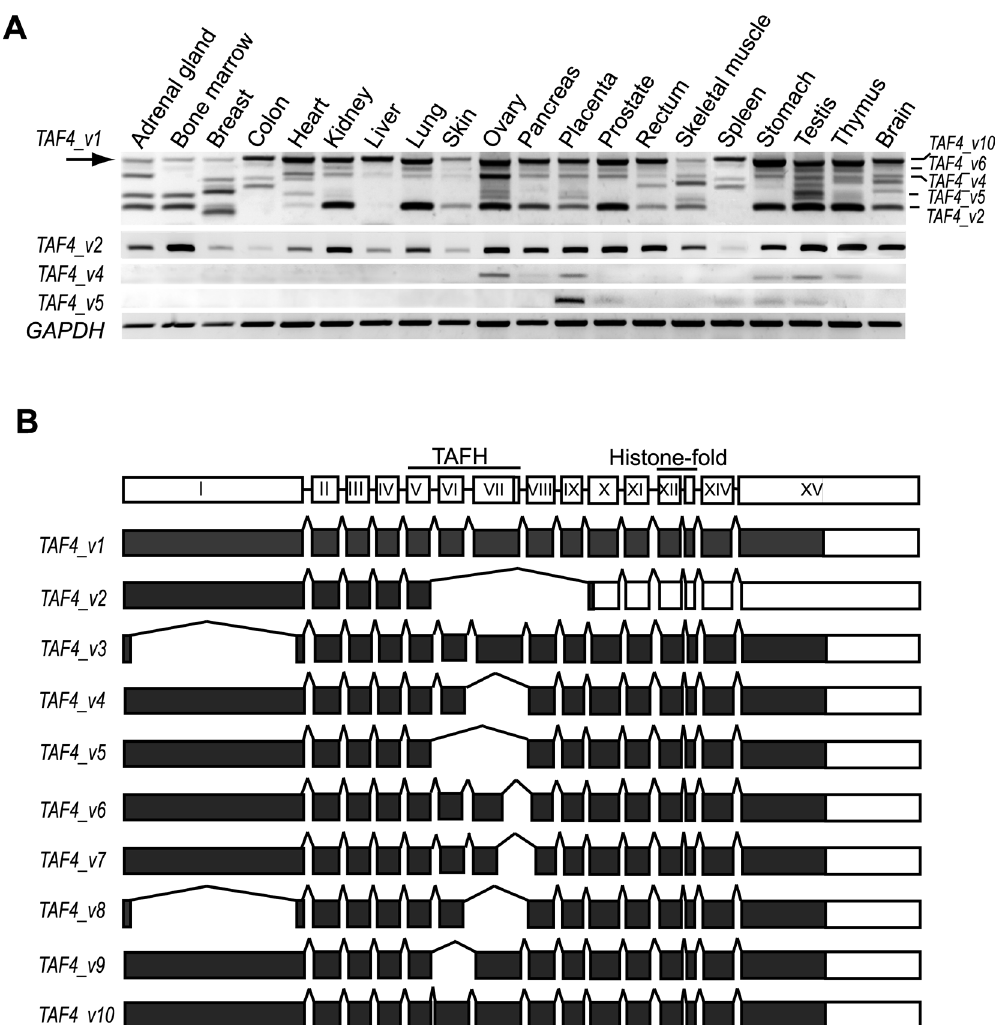
Figure 1. Expression analysis of TAF4 alternative splice variants in human tissues. ( A ) RT-PCR analysis of human tissues using TAF4 transcript-specific primers. Primers for the full-length TAF4_v1 amplify all splice variants, whereas ASV-specific primers generate predominantly one PCR product. The numbers of PCR cycles and exposure times of the images for each set of primers vary and cannot be directly compared. The arrow indicates the canonical TAF4_v1 ASV. ( B ) Schematic representation of the human TAF4 gene structure and its alternative splice variants drawn in scale. The regions encoding the respective domains are indicated above the gene structure. Filled boxes represent the coding regions of the ASVs.